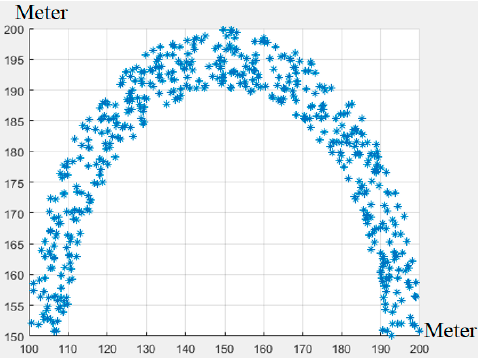
Figure 8. Swarm patterns with size 100 m× 50 m.